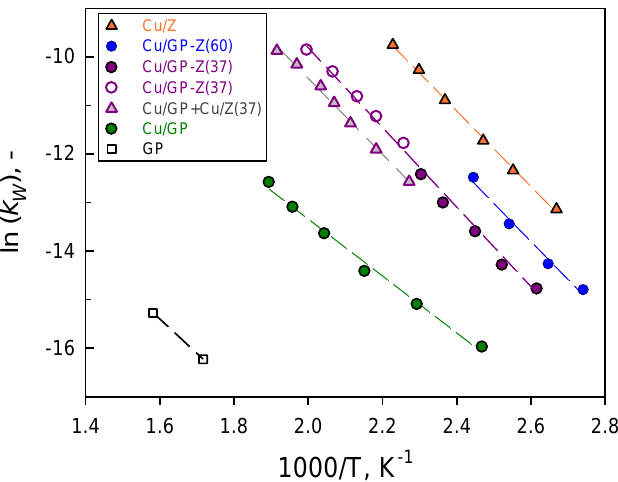
Figure 8. Arrhenius plots for the NO consumption rate per gram of catalyst during the NH 3 -SCR of